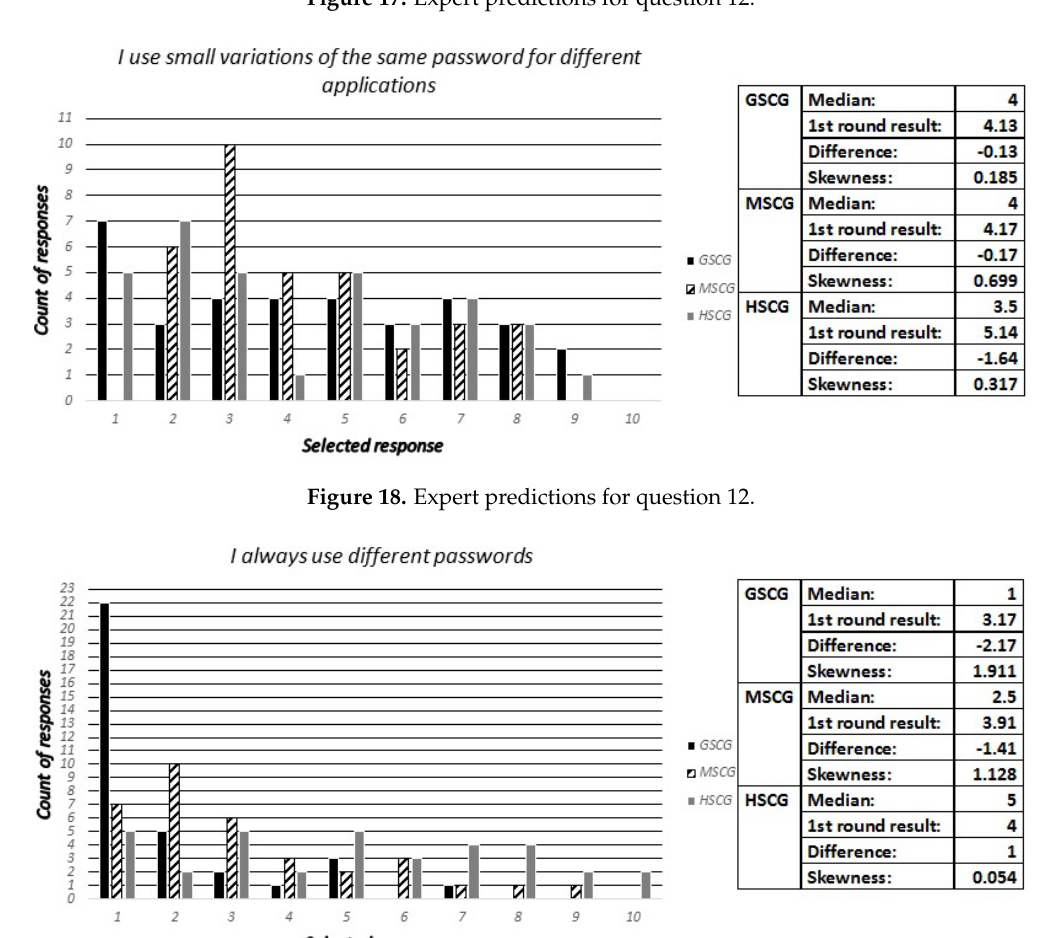
Figure 17. Expert predictions for question 12.